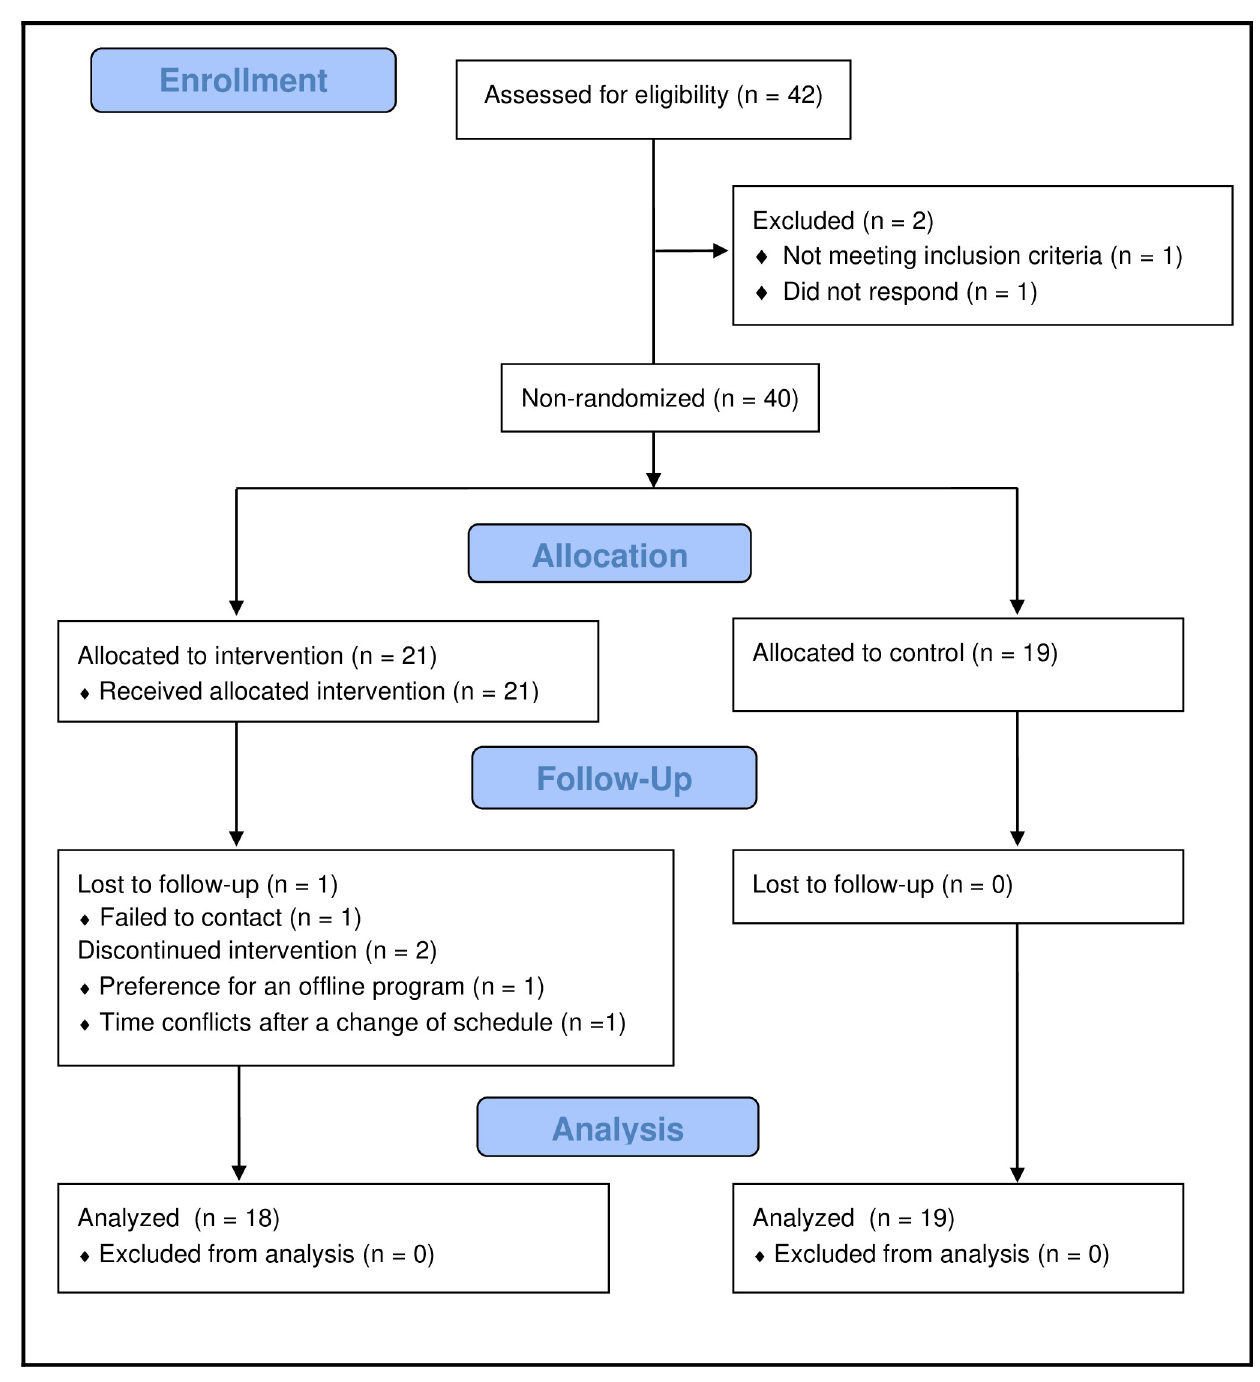
Fig 1. TREND flow